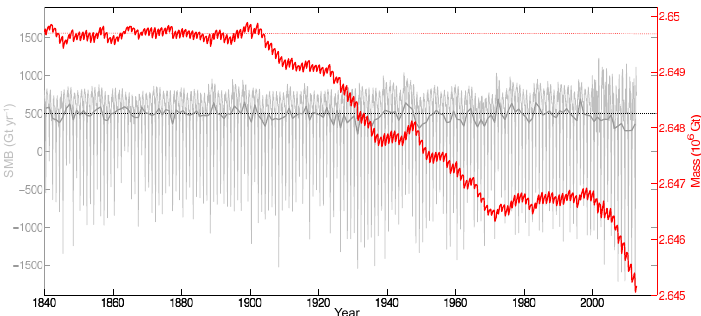
Figure 2. Time series of total ice sheet mass resulting from the Greenland ice sheet model historical spinup (solid red), compared to a control run (dashed red) of constant SMB climatological forcing, SMB (dashed black). For the historical simulation, ISSM is forced with monthly surface mass balance anomalies from 1840 to 2012 (Box, 2013). Monthly ice sheet total SMB forcing is plotted in light gray and yearly total SMB is presented in dark